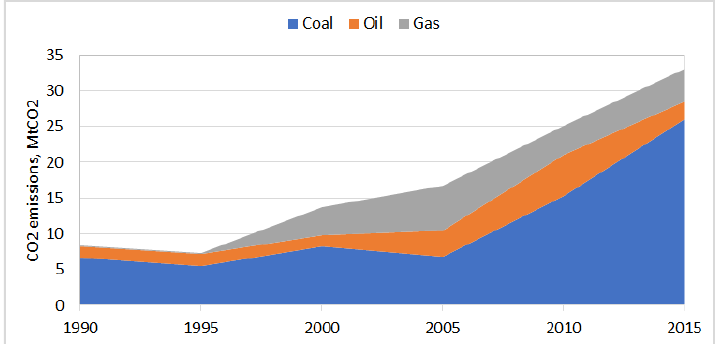
Figure 4. CO 2 emissions from electricity and heat by energy source–Chile [32].